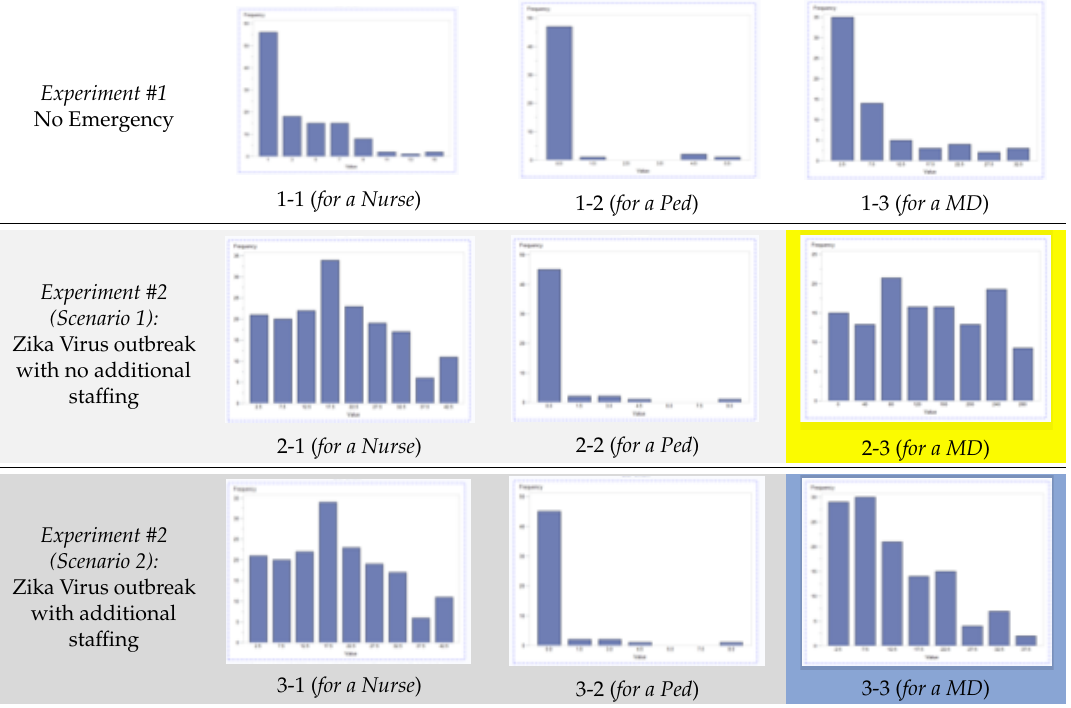
Table 4. Histograms of waiting time for patients during one day for each experiment.